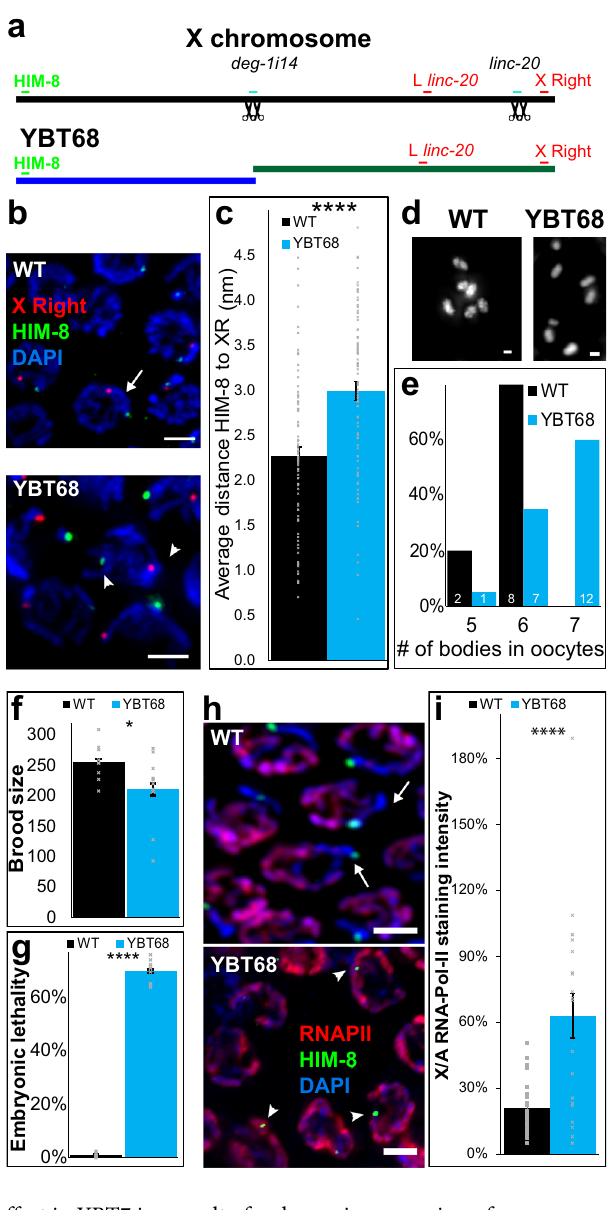
and Methods). In line with the bisection hypothesis, signals from of the X were present on the same DAPI-stained track in 100% of wild-type pachytene nuclei but only in 4% of YBT68 nuclei (Fig. 5b, n = 80, p value < 0.00001, Fisher exact test). The HIM-8 and FISH foci were spatially further from each other in YBT68 than in wild-type gonads (Fig. 5b, c, 3.0 ± 0.1 vs. 2.3 ± 0.1 μ M,